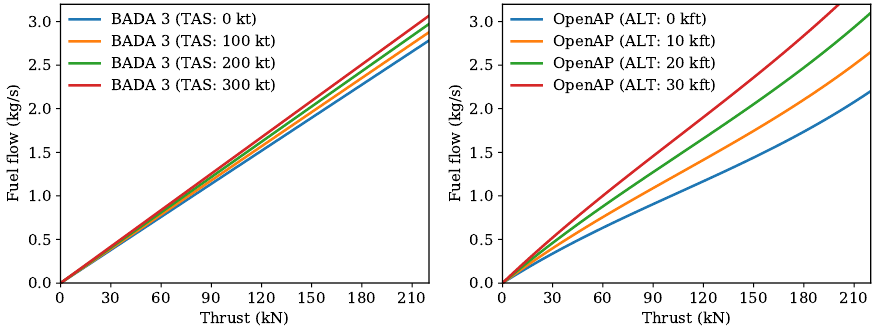
Figure 12. A320 maximum thrust (V2500-A1